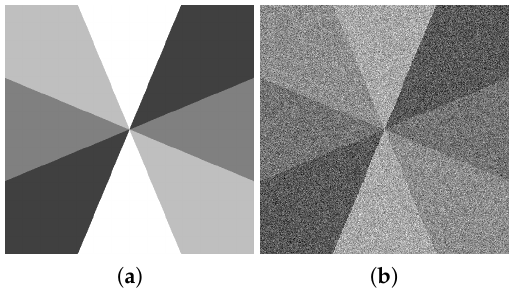
Figure 7. ( a ) The original four-valued image ( b ) with added noise.